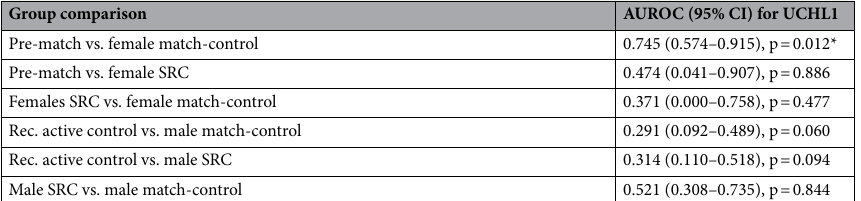
Table 5. Area under the receiver operating characteristic curve (AUROC) comparing sex-matched groups using serum. Ubiquitin carboxyl-terminal esterase L1 (UCHL1) concentration. Values are presented as AUROC (95% confidence interval), p-value (p), Rec. = recreationally, SRC = Sport-related concussion, * = significantly different (p = 0.012).